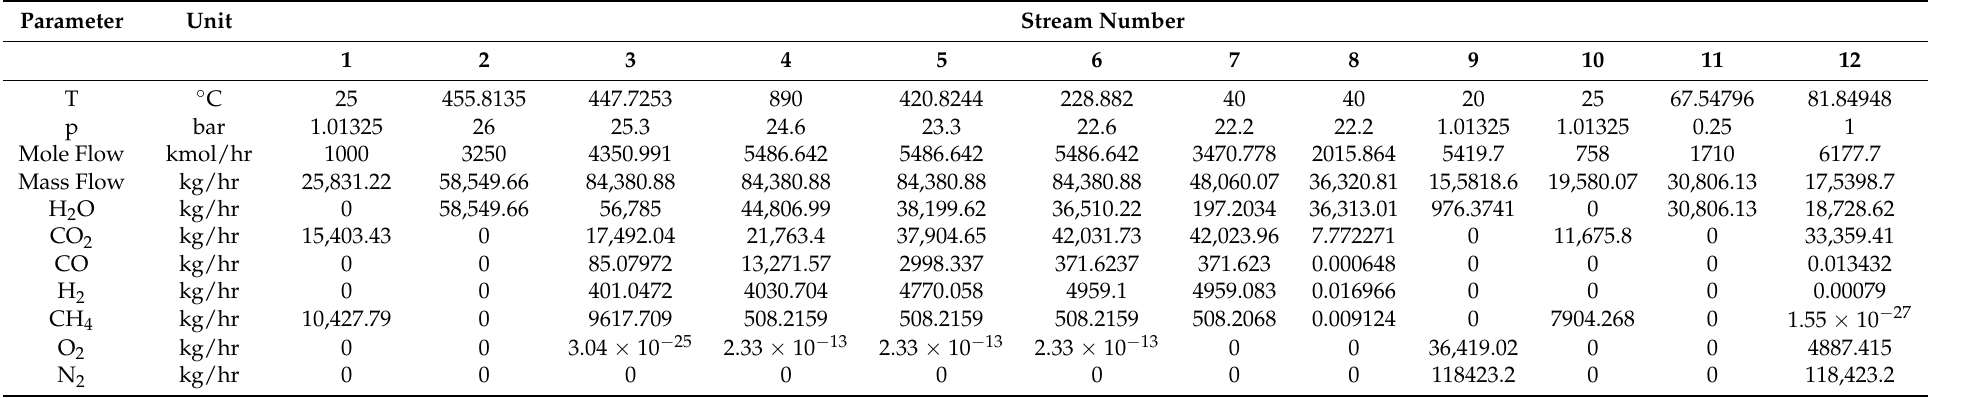
Table A4. Mass/mole flows in BIR process with temperature and pressure